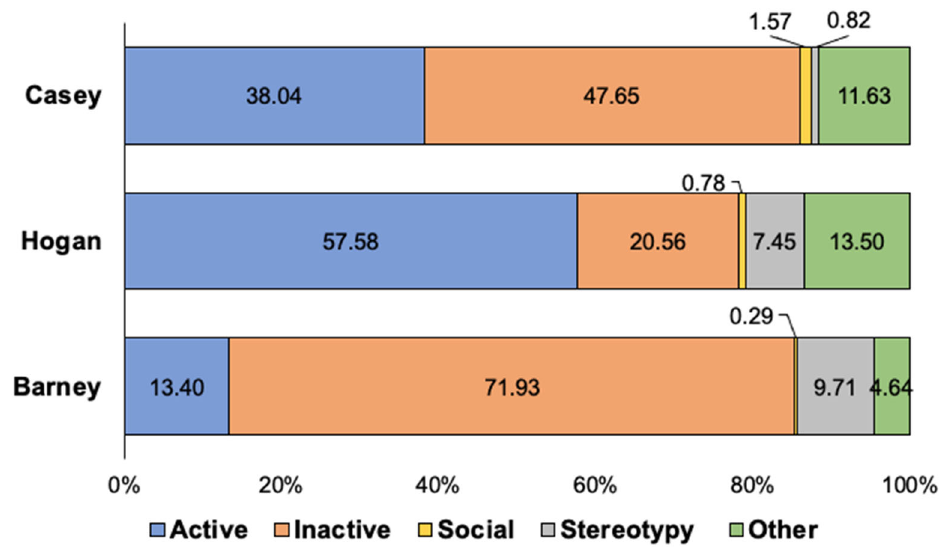
Figure 4. Average percentage of time that each of the three harbor seals spent engaging in each of the five classes of animal behavior (Active, Inactive, Social, Stereotypy, and Other) following the new introduction of Casey (post-introduction). Note. As averages, the total count for each seal does not equal 100 percent (~ 99.71 ‐ 99.97%).